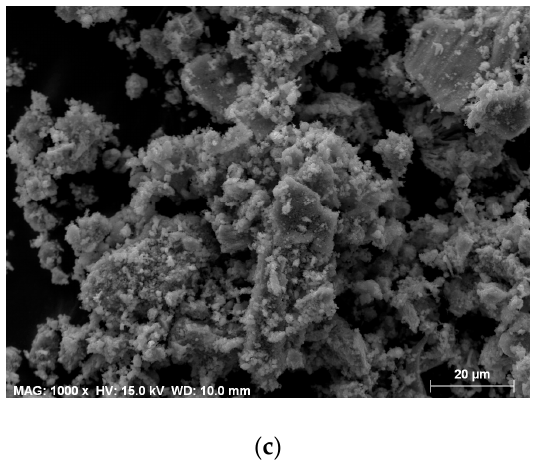
Figure 3. SEM images of the auto-combusted sample ( a ) energy-dispersive X-ray (EDX) analysis area, ( b ) the particles after auto-combustion and ( c ) the sample annealed at 600 °C.